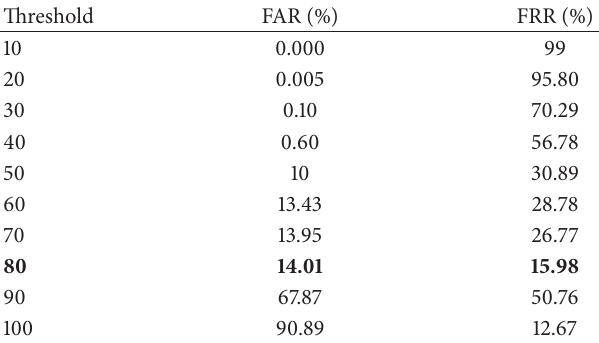
Table 4: Best FAR, FRR, and corresponding threshold using Experiment 3.